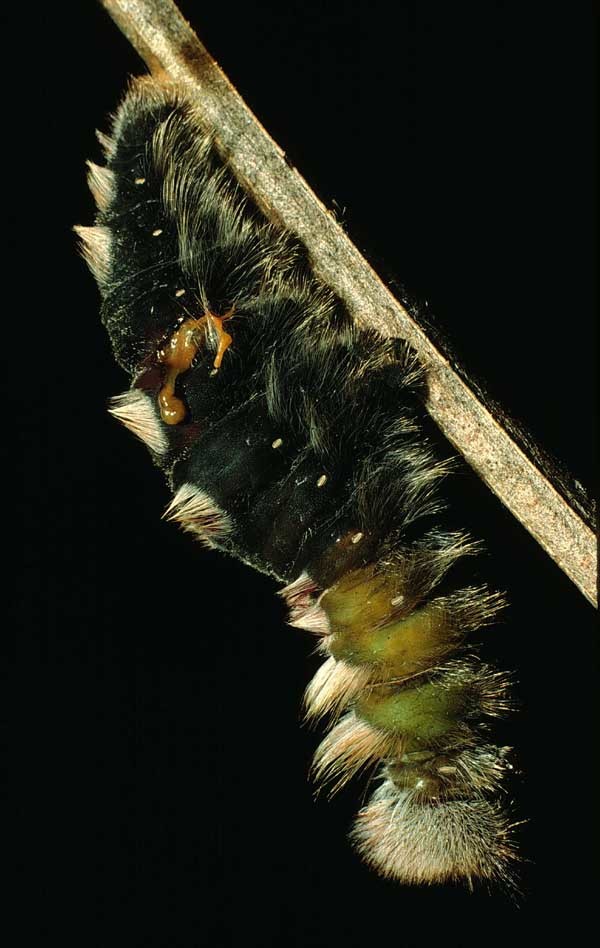
Morpho
p.
catalina voucher n. 95-SRNP-4612, feeding on Fabaceae, parasitized by Hyphantrophaga
morphophaga voucher n. DHJPAR0007354. Image voucher n. DHJ23257.jpg